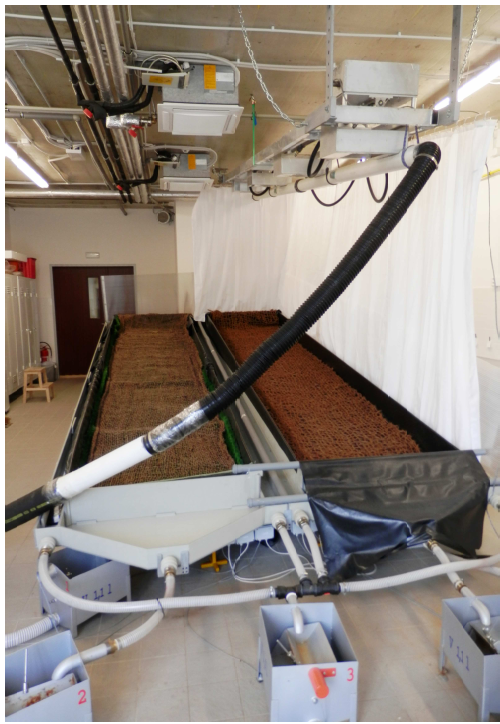
Figure 1. A Norton Ladder Rainfall Simulator is positioned above test beds with mechanical toggle flow meters. A C400 erosion con- trol net is spread over the test